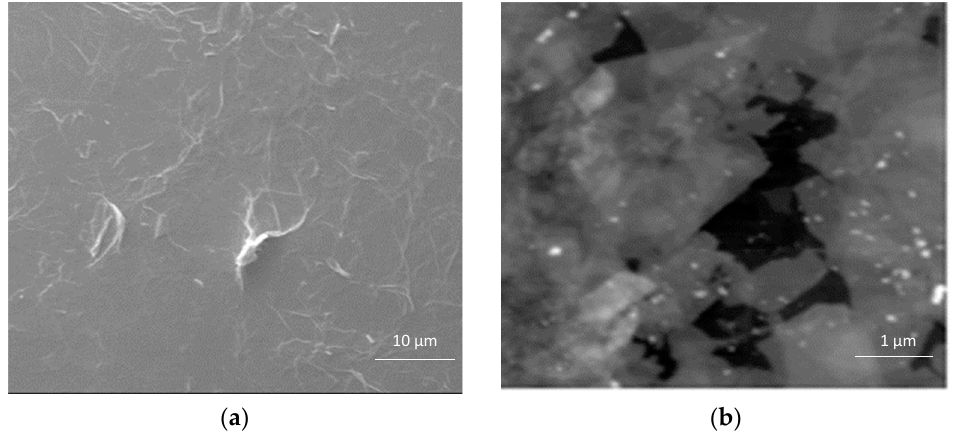
Figure 5. ( a ) SEM and ( b ) AFM images of 4 mg/mL GO − coated COC. The white lines in ( a ) represent the boundaries of the GO flakes.